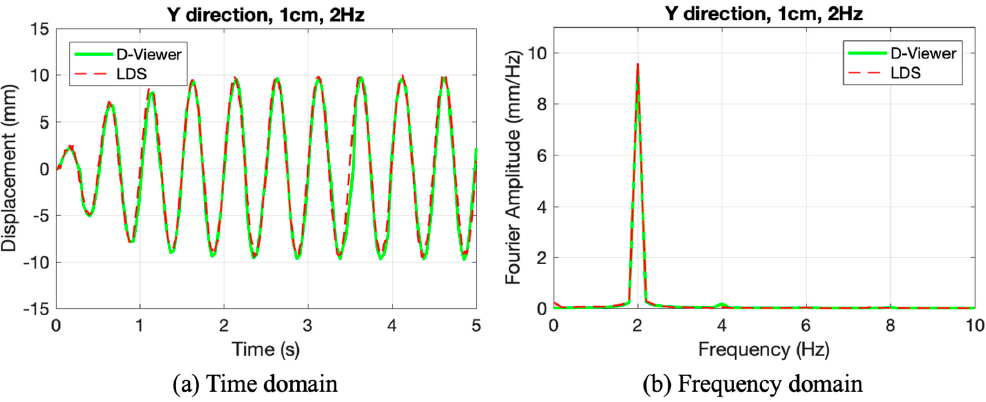
Figure 6. The results of the experiments #7: ( a ) Time domain; ( b ) Frequency domain.